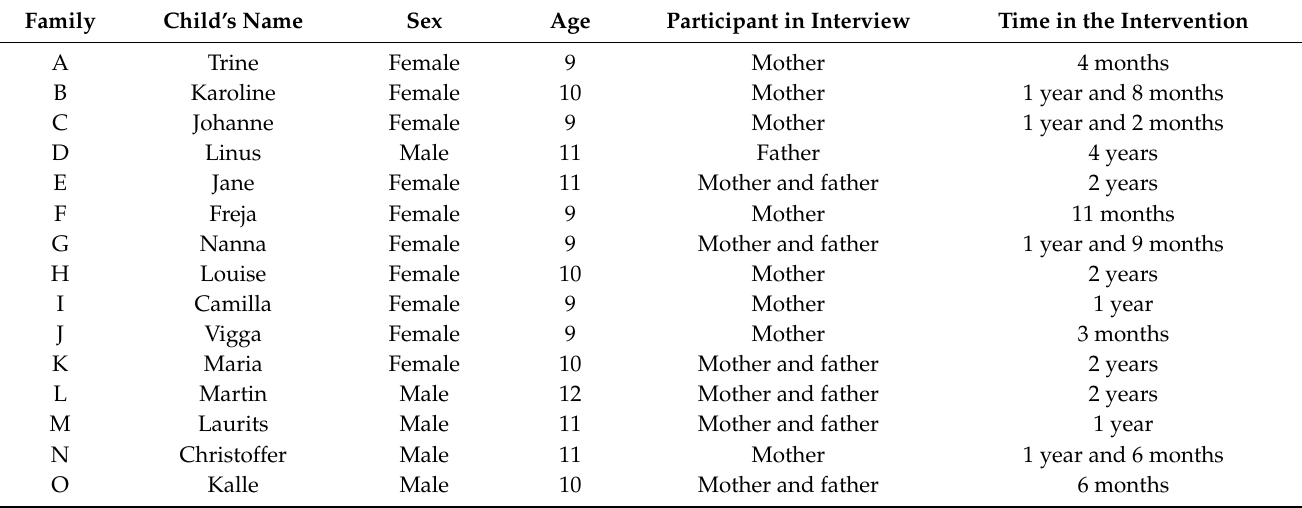
Table 1. Overview of the